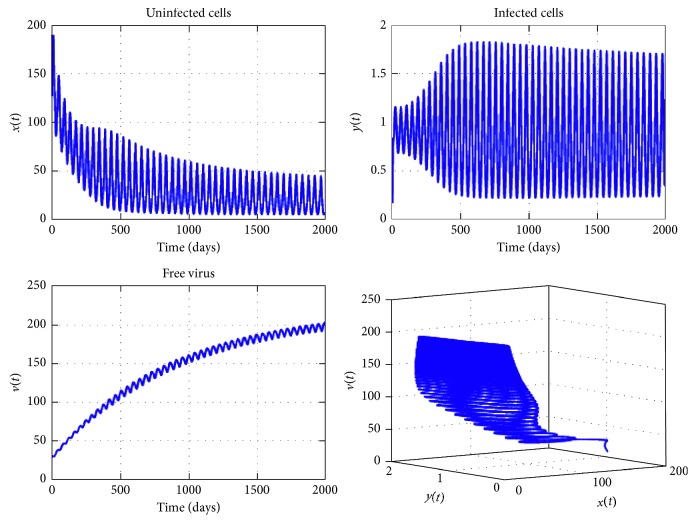
Dynamics of virotherapy when R0=1,5, β0=10−5, β1=10−4, and τ=7 < τ∗=8.8368. The initial conditions are x(0)=127, y(0)=0, and v(0)=30.